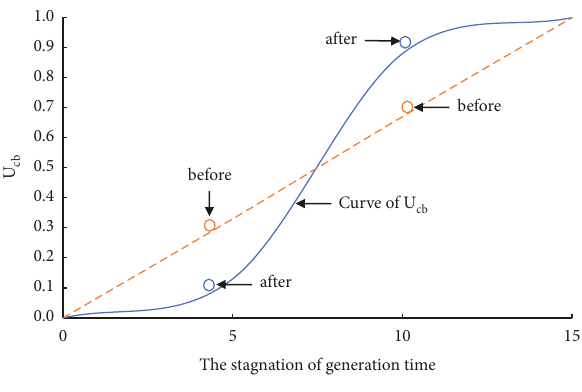
Figure 1: Adaptive curve of U